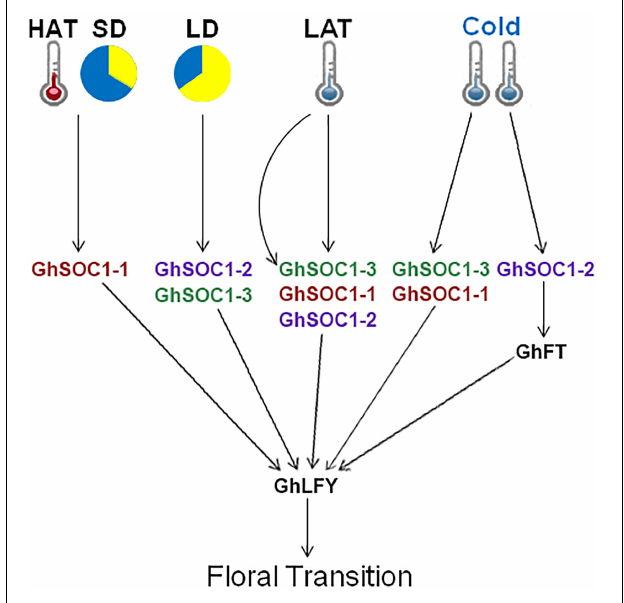
FIGURE 8 | Proposed regulatory model of GhSOC1s . HAT, high ambient temperature; LAT, low ambient temperature; LD, long-day condition; SD, short-day